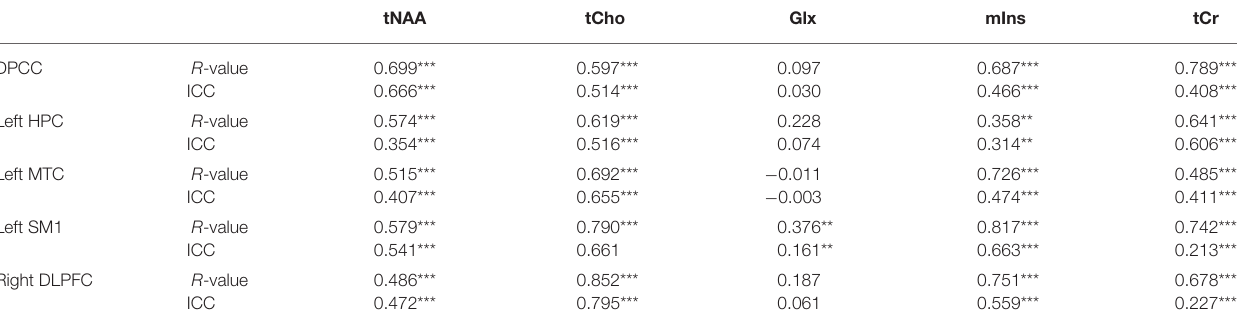
TABLE 1 | Agreement between LCModel and Tarquin 1 H-MRS post-processing software